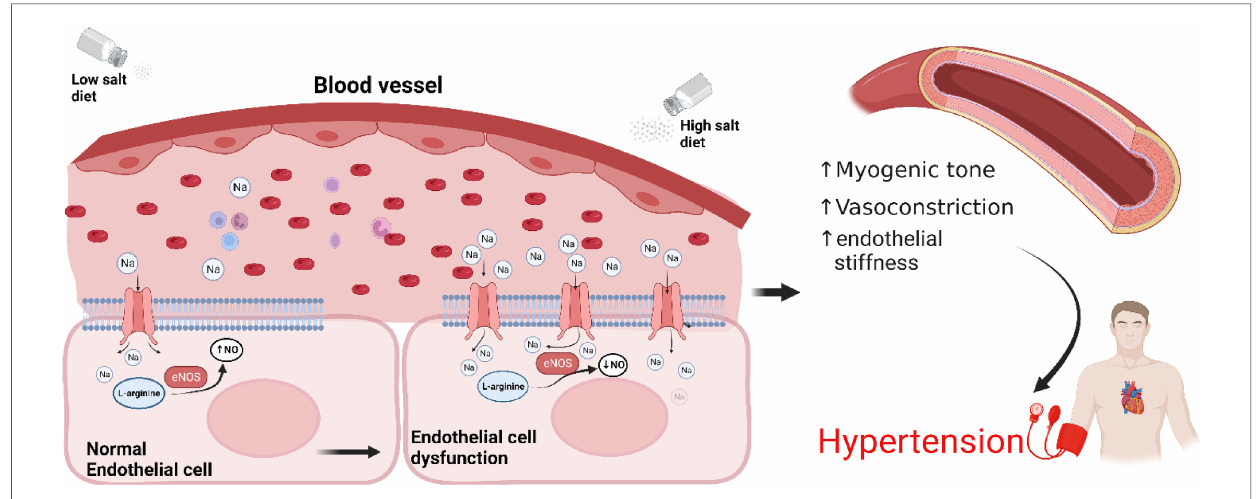
FIGURE 2 Sodium induces an ENaC-dependent transition from endothelial function to dysfunction . High salt diet leads to overexpression of ENaC and reduced nitric oxide production, increased myogenic tone, vasoconstriction, arterial stiffness resulting in hypertension. Endothelial cells at the bottom have been enlarged for illustration purposes. NO, nitric oxide; eNOS, endothelial nitric oxide